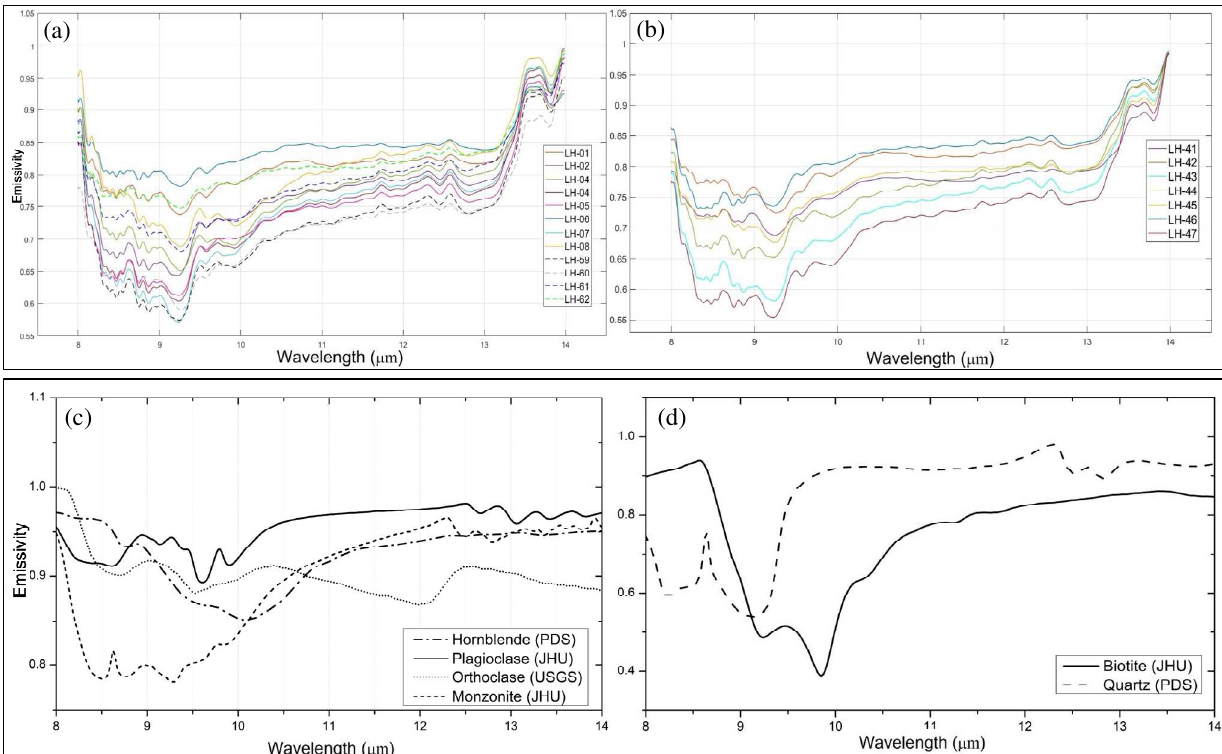
Figure 7. Rock sample emissivity curves. ( a ) LHW sample group. ( b ) LHE sample group. ( c ) Refer- ence spectra of monzonite and pure minerals in spectral libraries, including hornblende, plagioclase and orthoclase. ( d ) Reference spectra of biotite and quartz from spectral libraries.